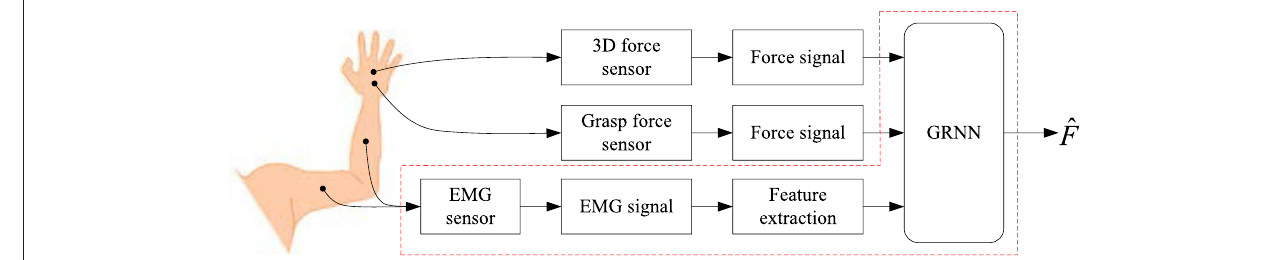
FIGURE 9 | The diagram of the force estimation.